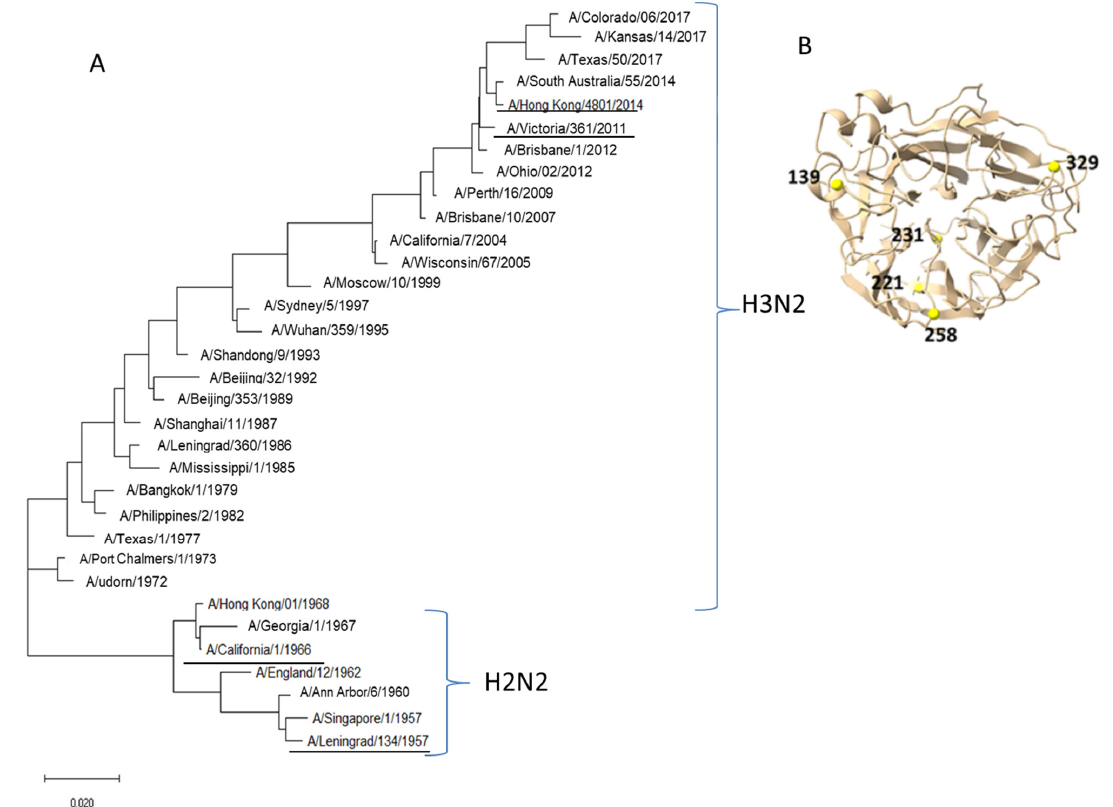
Figure 1. Phylogenetic analysis of NA of A/H2N2 and A/H3N2 influenza viruses. ( A ). The evolutionary history was inferred using the Neighbor-Joining method [14]. The optimal tree with the sum of branch length = 0.39463486 is shown. The tree is drawn to scale, with branch lengths in the same units as those of the evolutionary distances used to infer the phylogenetic tree. The evolutionary distances were computed using the Poisson correction method [15] and are in the units of the number of amino acid substitutions per site. This analysis involved 33 amino acid sequences. All ambiguous positions were removed for each sequence pair (pairwise deletion option). There was a total of 469 positions in the final dataset. ( B ). Spatial model of the globular part of NA (AA 83-469). Amino acids that are different in strains A/Hong Kong/4801/2014(H3N2) and A/Victoria/361/2011(H3N2) were noted.